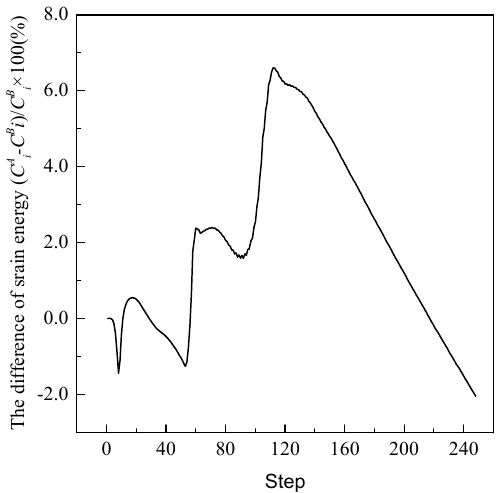
Figure 6. The change ratio of the strain energy of Scheme A and B.